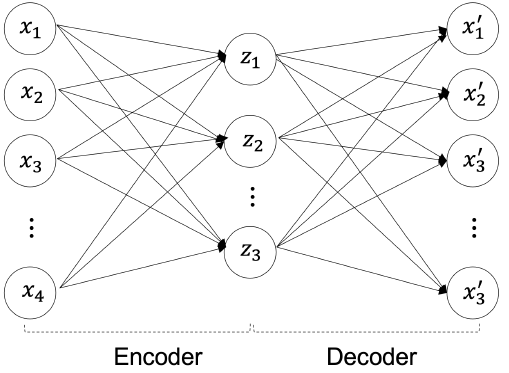
Figure 1. Autoencoder (AE)